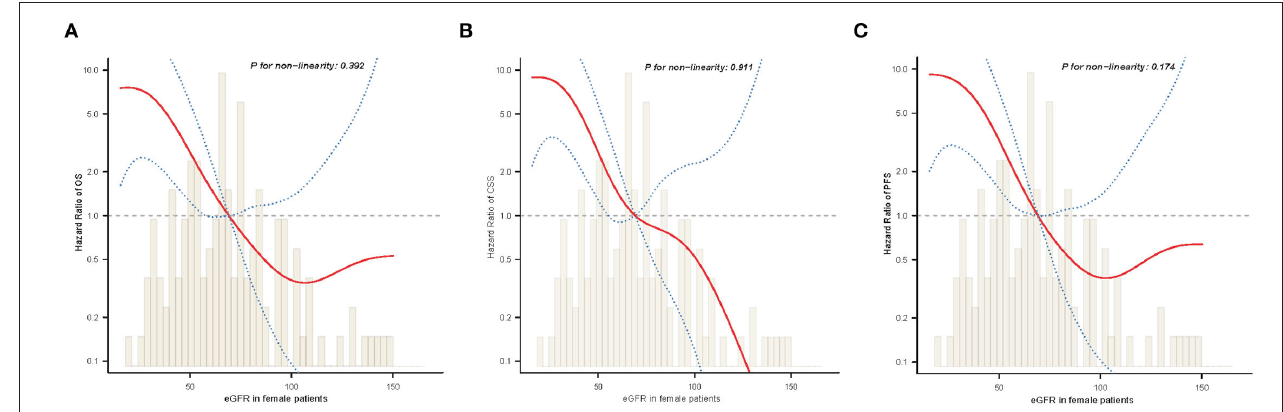
FIGURE 5 | The adjusted smooth fitting curve between postoperative eGFR and postoperative survival outcomes of female UTUC patients. A linear relationship between postoperative eGFR and OS (A) , CSS (B) , PFS (C) was observed (all P > 0.05). The red solid line and blue dashed line represent the estimated values and their corresponding 95% confidence intervals. UTUC, upper tract urothelial carcinoma; eGFR, estimated glomerular filtration rate; OS, overall survival; CSS, cancer-specific survival; PFS, progression free survival.